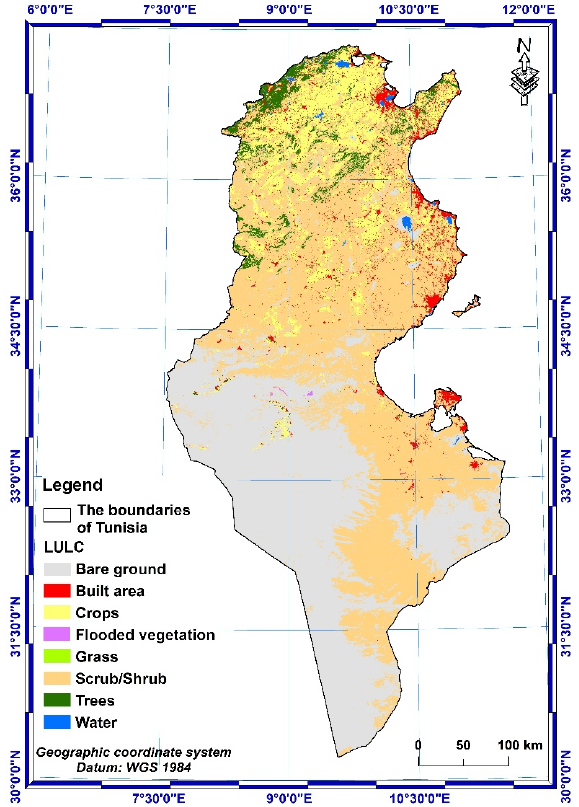
Figure 11. Land Use–Land Cover map of Tunisia.